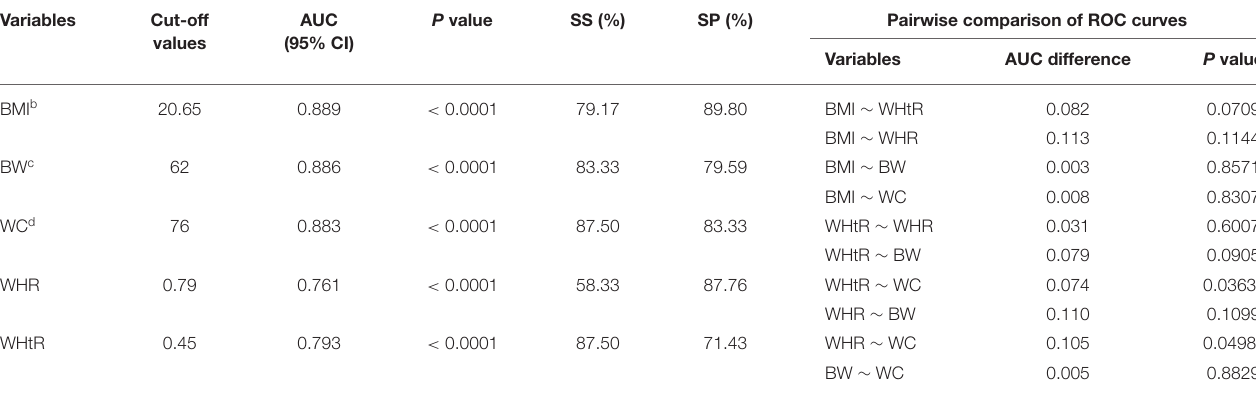
Variables AUC difference P value